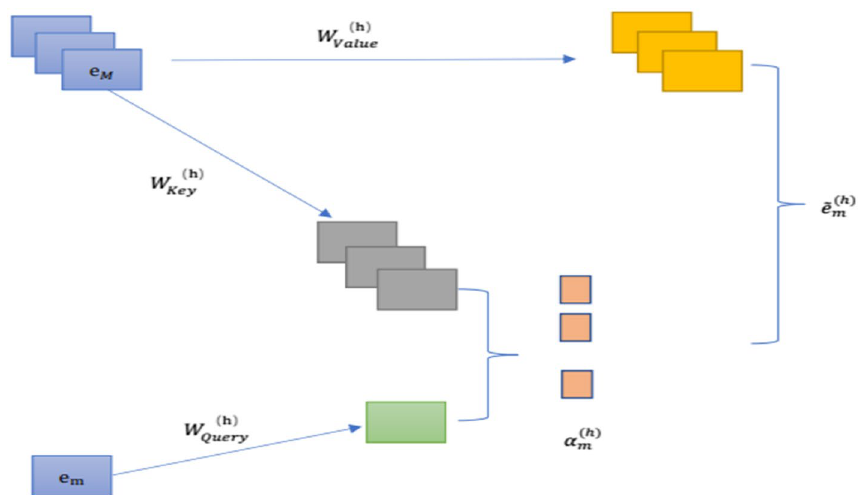
Fig. 3 The architecture of interacting layer. Combinatorial features are conditioned on attention weights, i.e., α ( h )